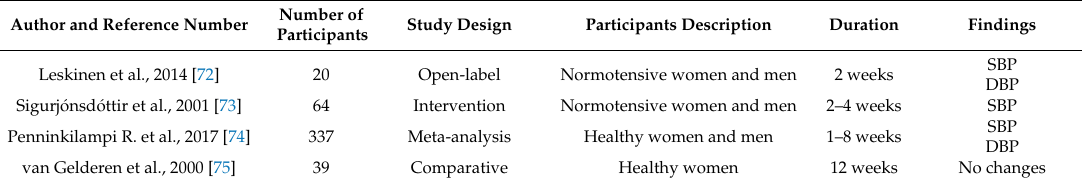
Table 6. Comparison of